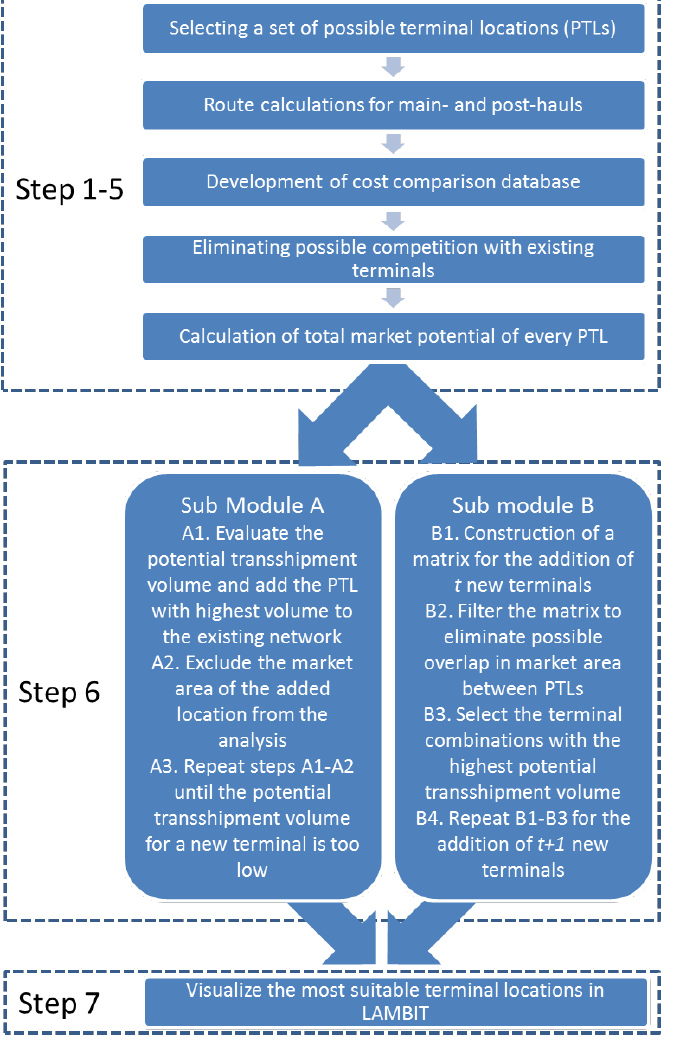
Figure 3. Optimal terminal location module